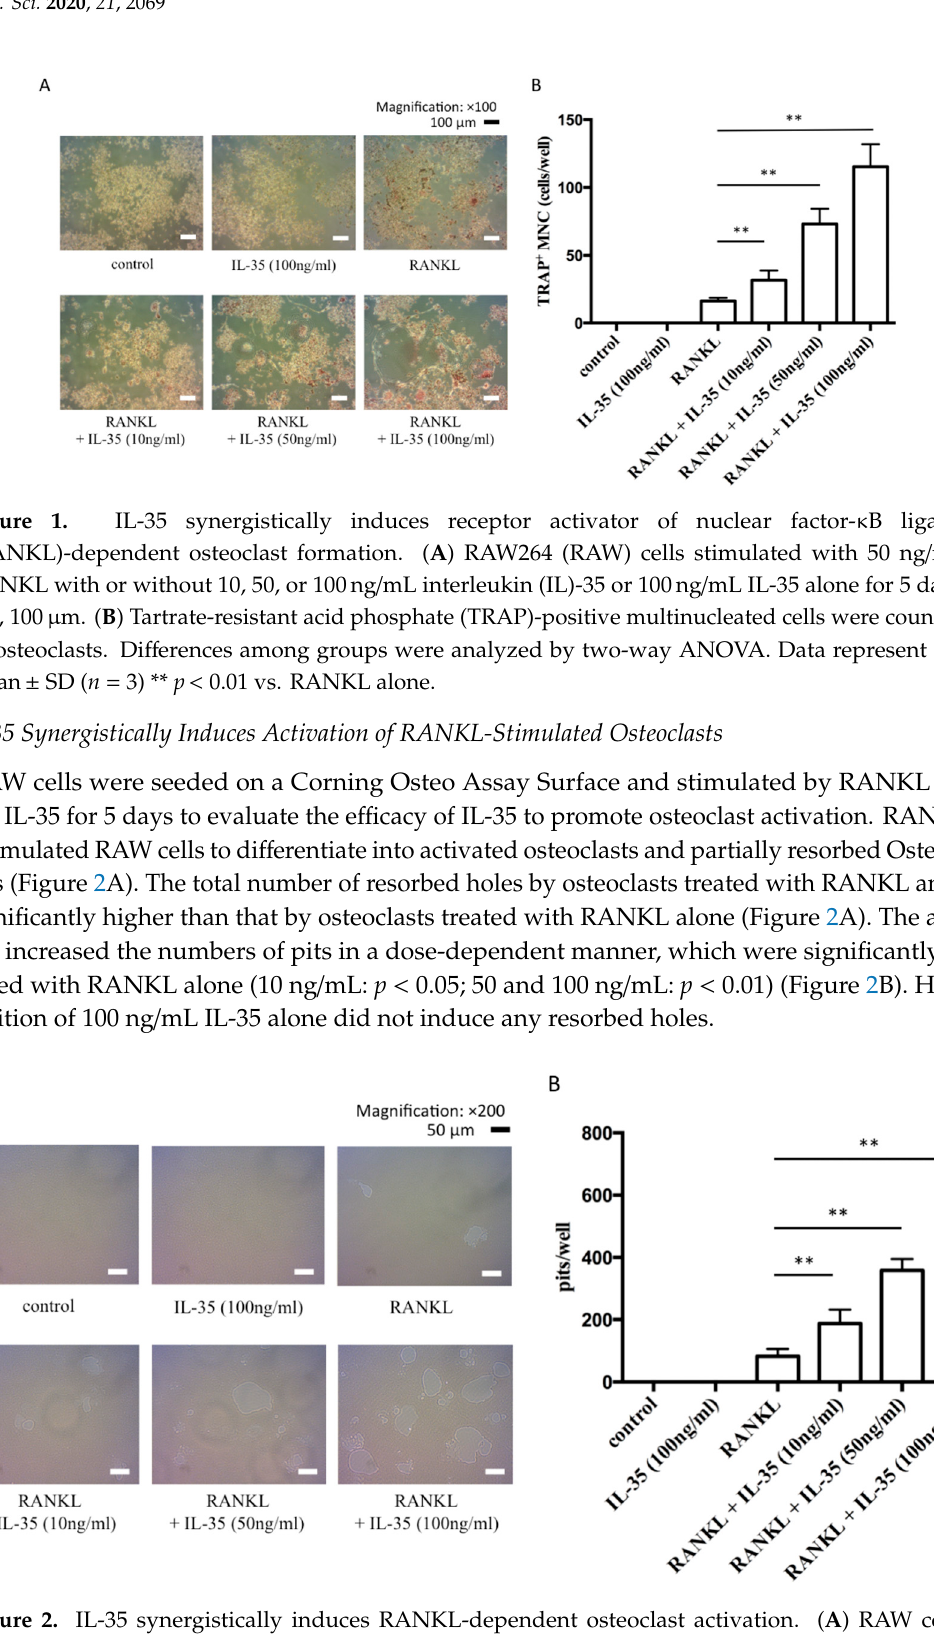
Figure 2. IL-35 synergistically induces RANKL-dependent osteoclast activation. ( A ) RAW cells stimulated with 50 ng/mL RANKL with or without 10, 50, or 100 ng/mL IL-35 or 100 ng/mL IL-35 alone for 5 days on the Corning Osteo Assay Surface. Bar, 50 µm. ( B ) Formed pits were counted to indicate osteoclast activation. Differences among groups were analyzed by two-way ANOVA. Data represent the mean ± SD ( n = 3). ** p < 0.01 vs. RANKL alone. 2.3. IL-35 Synergistically Induces Regulation of Osteoclastic Markers in RANKL-Stimulated RAW Cells RANKL-inductive specific genes are associated with osteoclast differentiation. Quantitative polymerase chain reaction (qPCR) analysis was used to determine the effect of IL-35 on expression of RANKL-inductive specific genes. RANKL significantly increased the mRNA expression of matrix metalloproteinase (MMP)-9, cathepsin K, TRAP, and nuclear factor of activated T cells (NFAT) c1 in RAW cells, and the addition of IL-35 induced expression all RANKL-inductive specific genes in a dose-dependent manner. Notably, the expression of genes modulated by RANKL together with 100 ng/mL IL-35 was significantly higher compared with that by RANKL alone ( p < 0.01) (Figure 3). However, the addition of 100 ng/mL IL-35 alone did not induce any specific genes. In addition, chloride channel 7 (CLCN7) gene expression did not change with any stimuli in this study. These results indicate that IL-35 induces certain genes associated with osteoclast differentiation induced by RANKL.